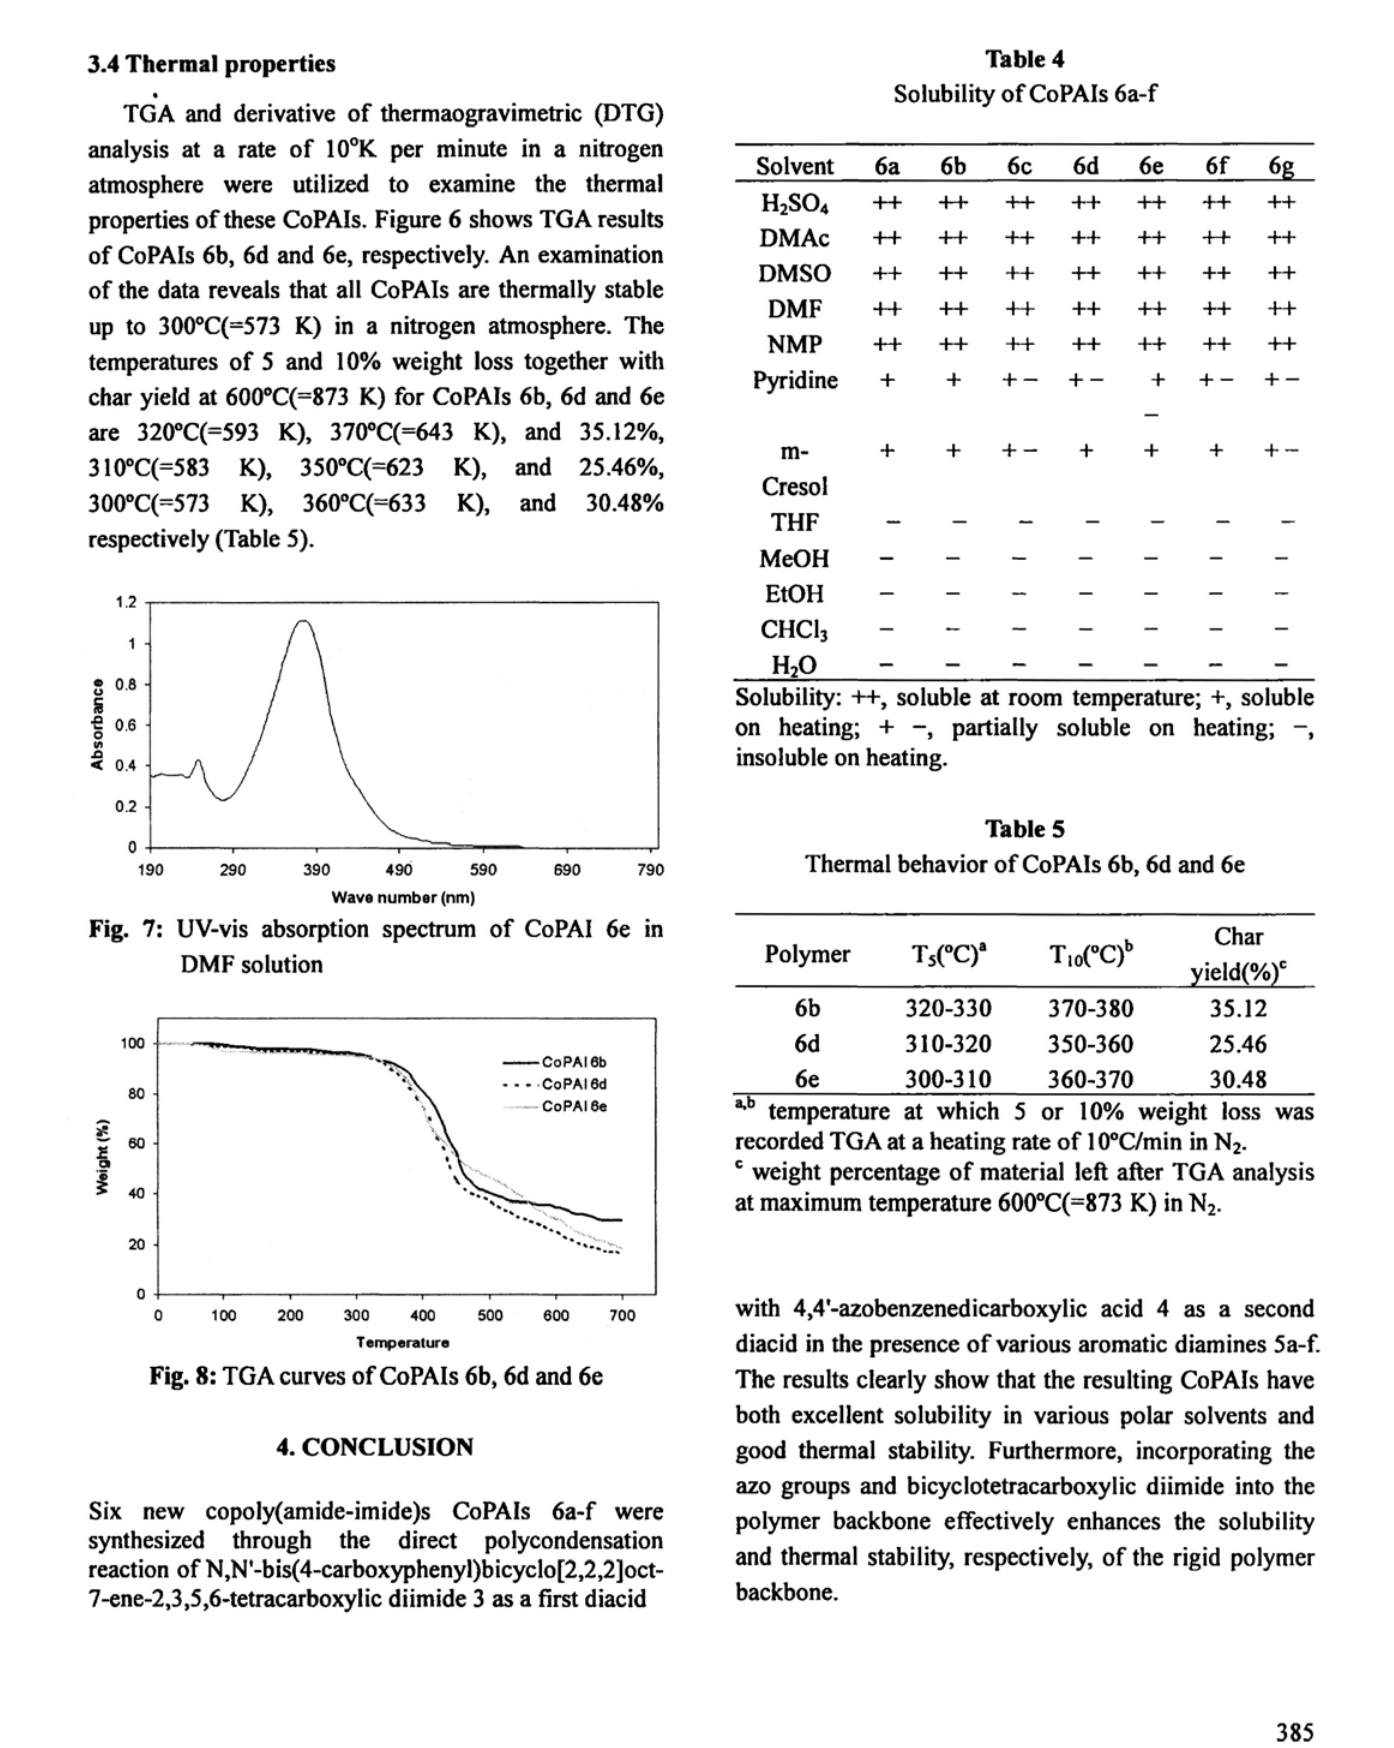
Fig. 8: TGA curves of CoPAIs 6b, 6d and